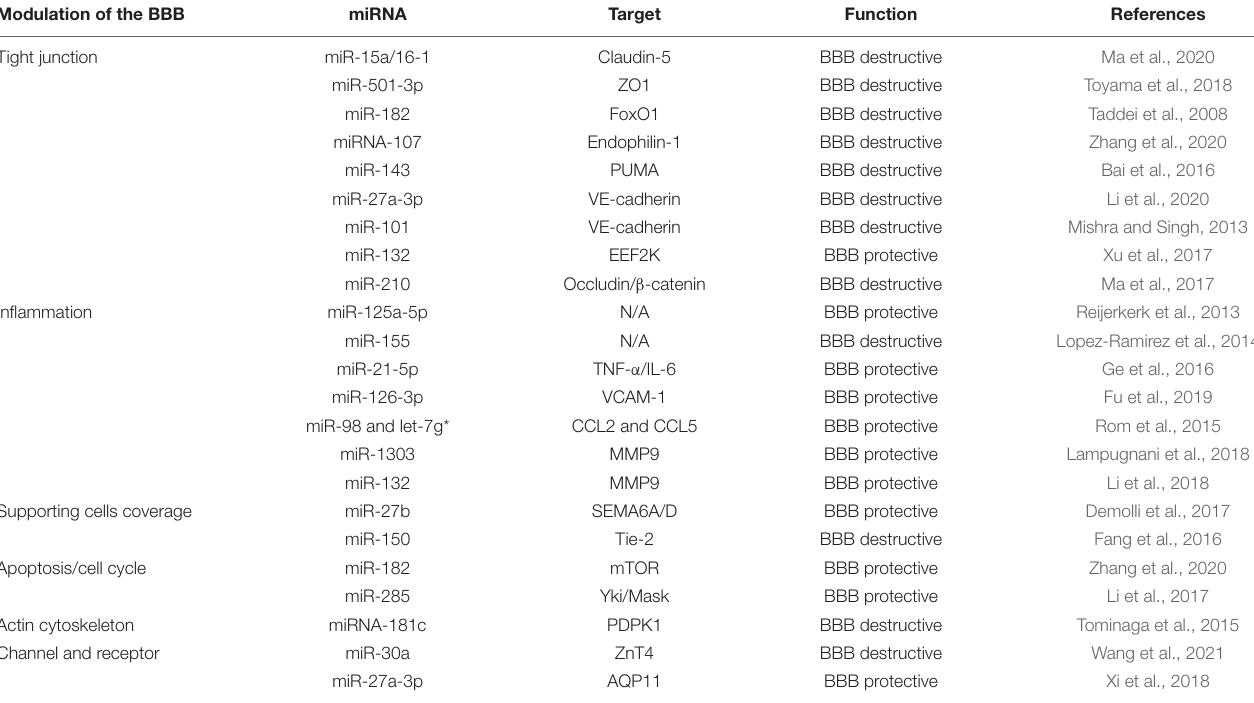
TABLE 1 | The effect of microRNAs (miRNAs) on blood–brain barrier (BBB) integrity. Modulation of the BBB